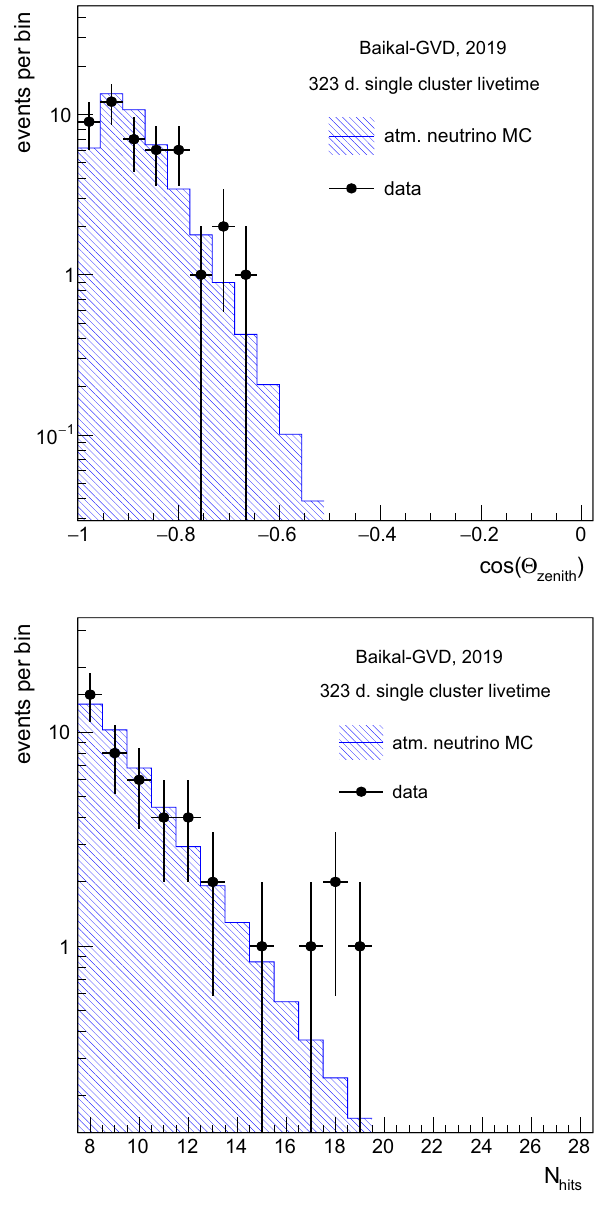
Fig. 4 Results of the search for upgoing track-like neutrino events in the 2019 dataset (323 days single-cluster equivalent livetime). Top: zenith angle distribution. Bottom: distribution of the number of hits used in reconstruction. The black points and the blue filled area show the Baikal-GVD data and the MC prediction for atmospheric neutrinos, respectively. The expected number of background atmospheric muon events after the quality cuts is (cid:2) 1 and is therefore not